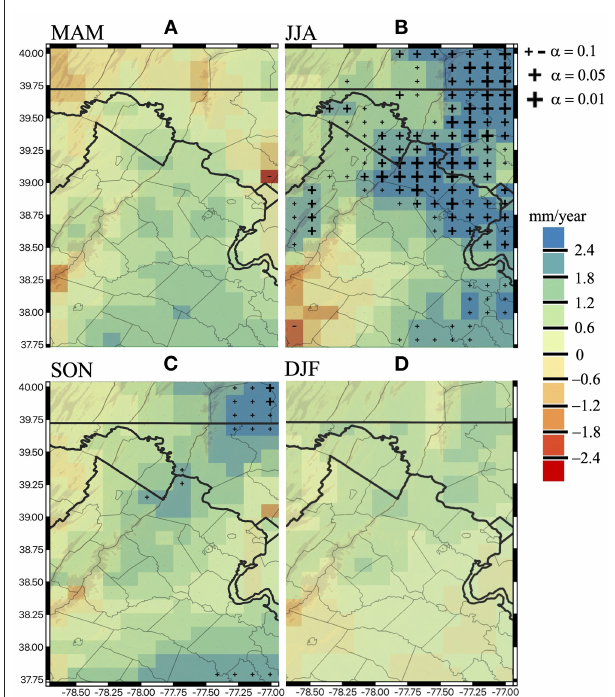
FIGURE 6 | Theil-Sen trends of seasonal precipitation totals (1980–2018) for (A) spring (March–April–May), (B) summer (June–July–August), (C) fall